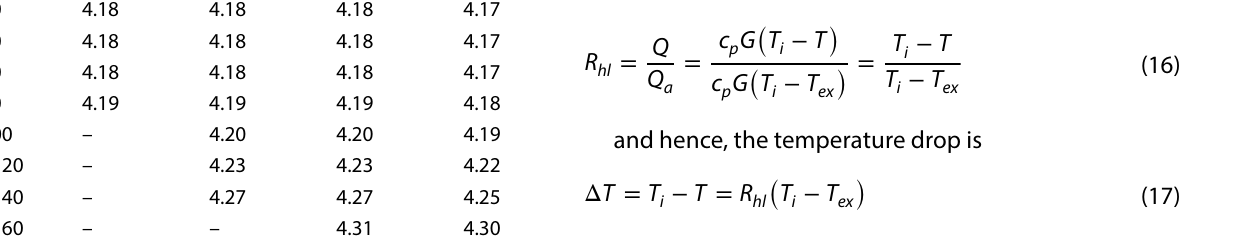
Here unit of the average specific heat is kJ kg −1 K −1 , “–” means that there is no relevant data in the literature for calculation